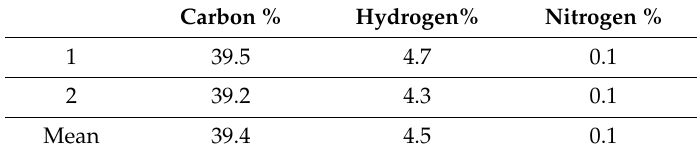
Figure 3. X-ray diffraction pattern (XRD) of the membrane sample. Observe the peaks representing hydroxyapatite and β -TCP. The quantitative analysis showed the presence of two phases: 45.8% β - TCP and 54.2% HA.